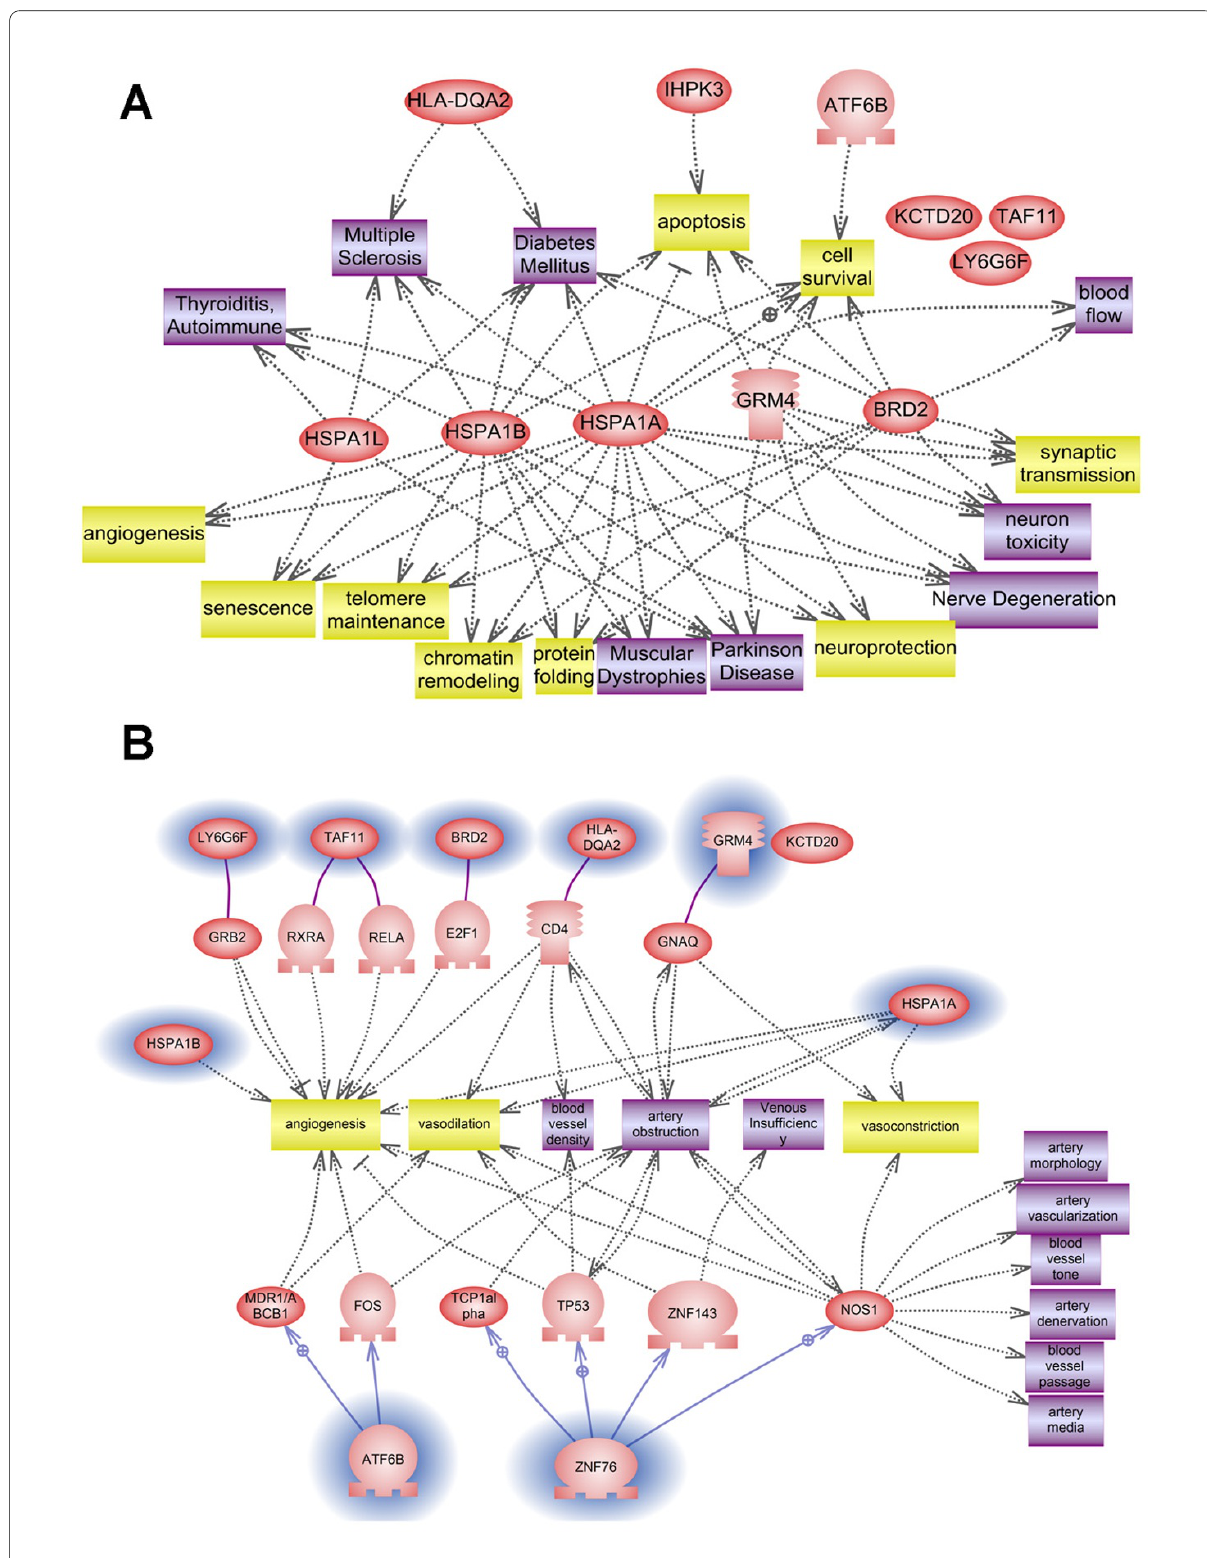
Figure 4 Functional links of the known genes within the HLA locus networking in neurodegeneration, multiple sclerosis and immunity dis- orders (A) and angiogenesis and venous formation pathways (B)